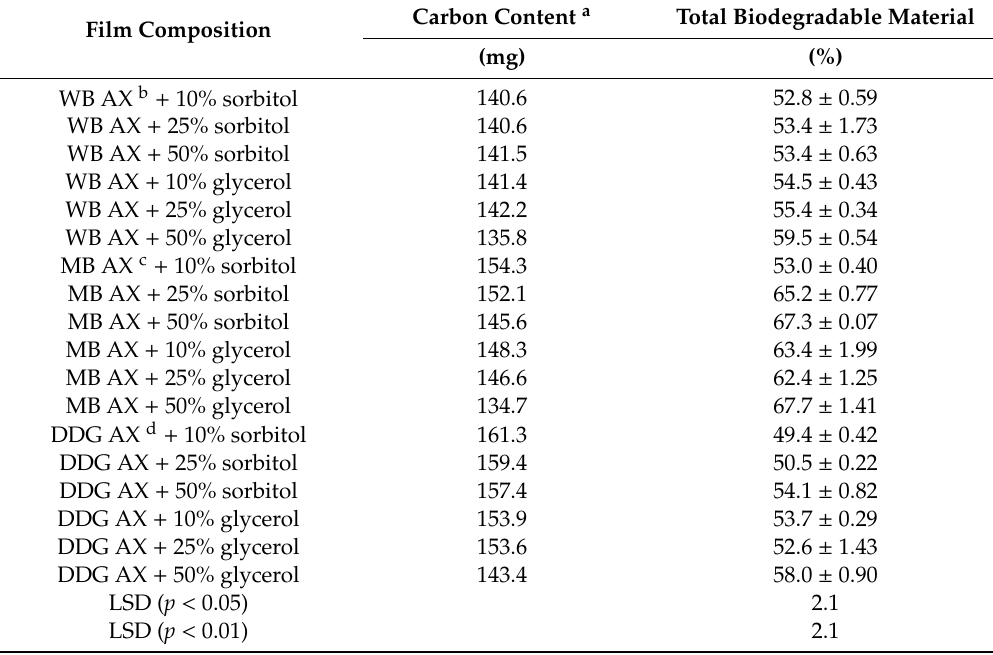
Table4. Carboncontentsandtotalbiodegradablematerialofarabinoxylanfilmsmadewitharabinoxylan extracted from wheat bran, maize bran, or dried distillers